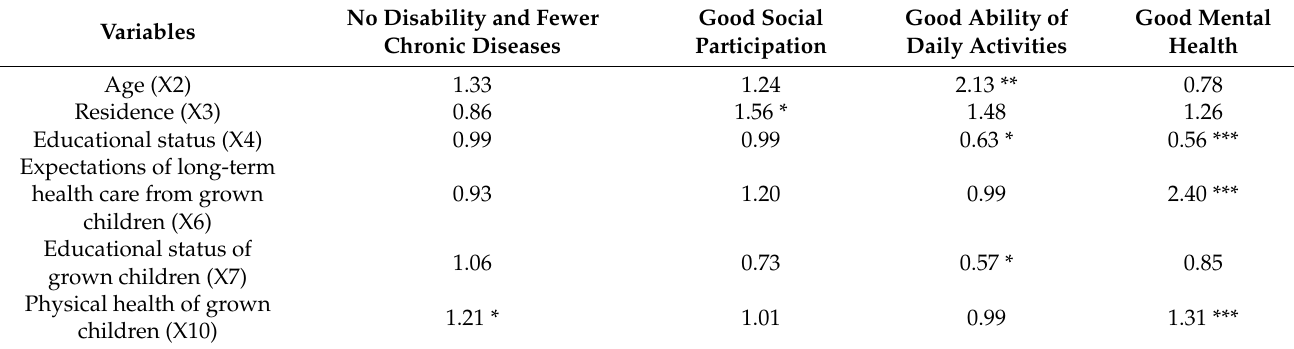
Table 5. Logistic regression of the main indicators to the four criteria of